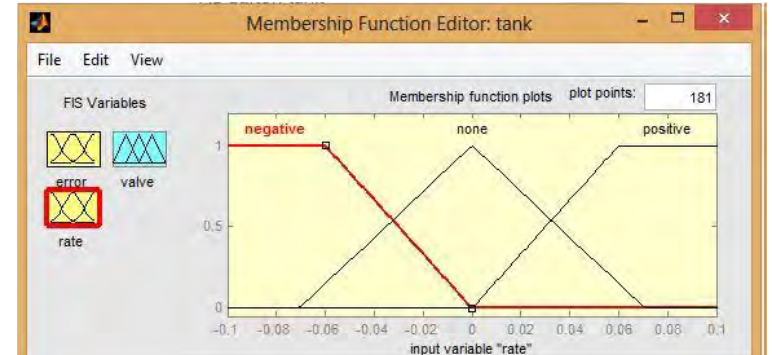
Figure 10. (b) membership of rate of error